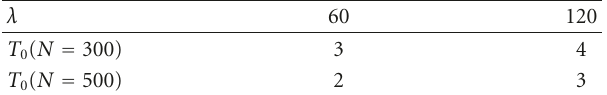
Table 3: T 0 , the forwarding bound, used in Test 5. λ 60 120 T 0 ( N =